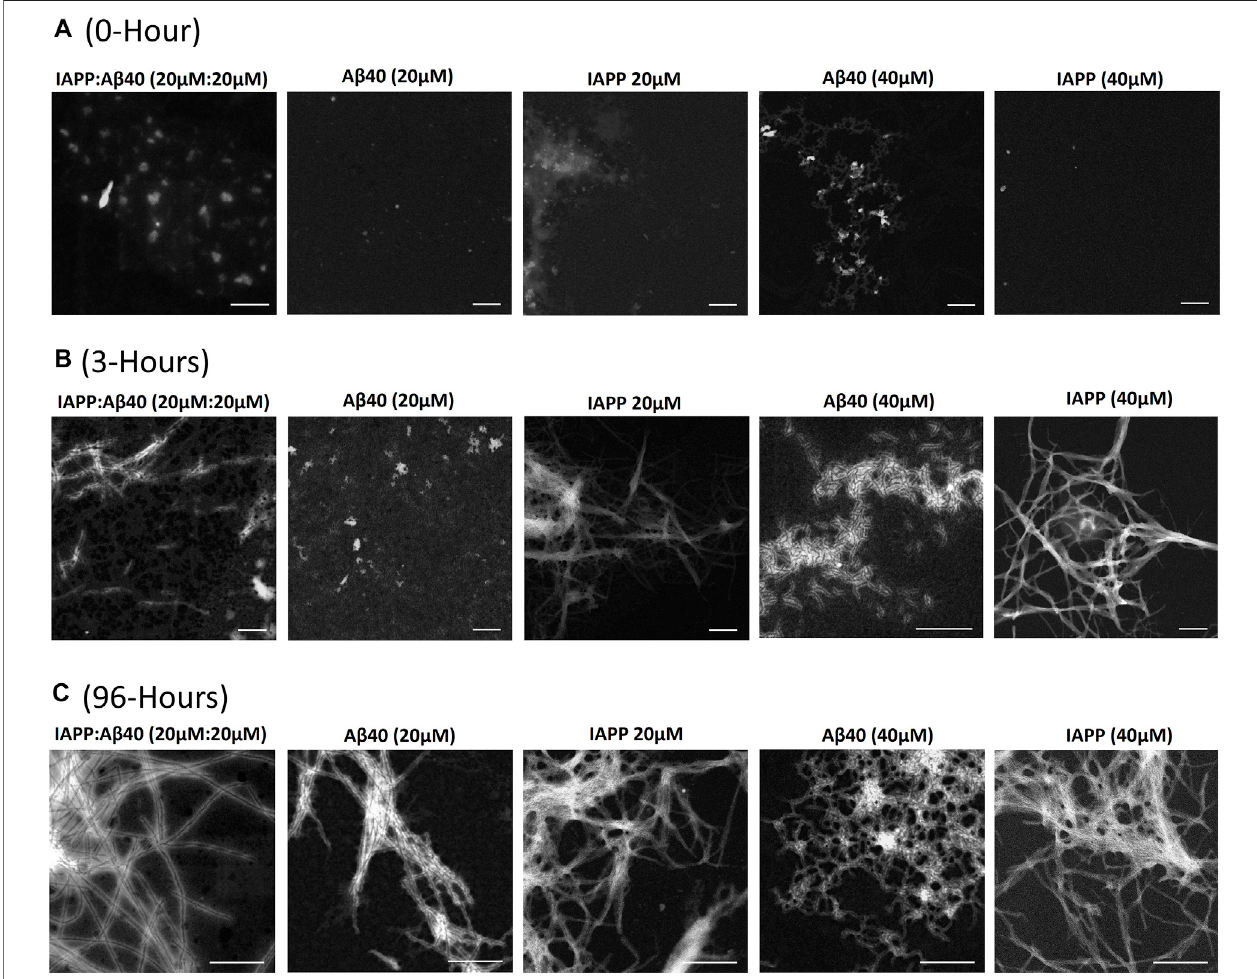
FIGURE 2 | Morphological characterization using scanning transmission electron microscopy (STEM) of (A) 0-Hour, (B) 3-Hours, and (C) 96-Hours assemblies formed by the co-aggregation of IAPP-A β 40 (20 µM:20 µM), as well as those formed by the self-aggregation of IAPP alone (20 and 40 µM) and A β 40 alone (20 and 40 µM). All scale bars represent 200